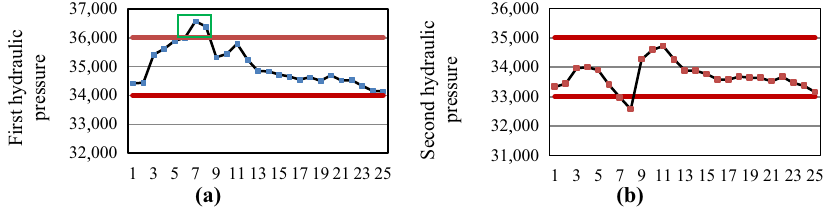
Figure 2. There are tendency chart from two data sequences of